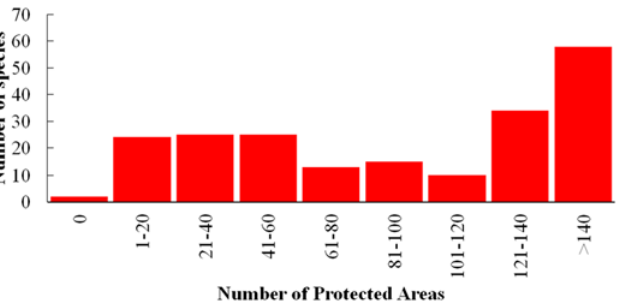
Fig 2. Frequency distribution of mammal species represented in all protected areas of Costa Rica. Note that most species were represented in at least 1 protected area and 48% of all species (100 species) were represented in more than 100 protected areas.